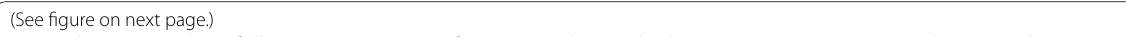
tional file 1: Fig. S1), the isoprene production of